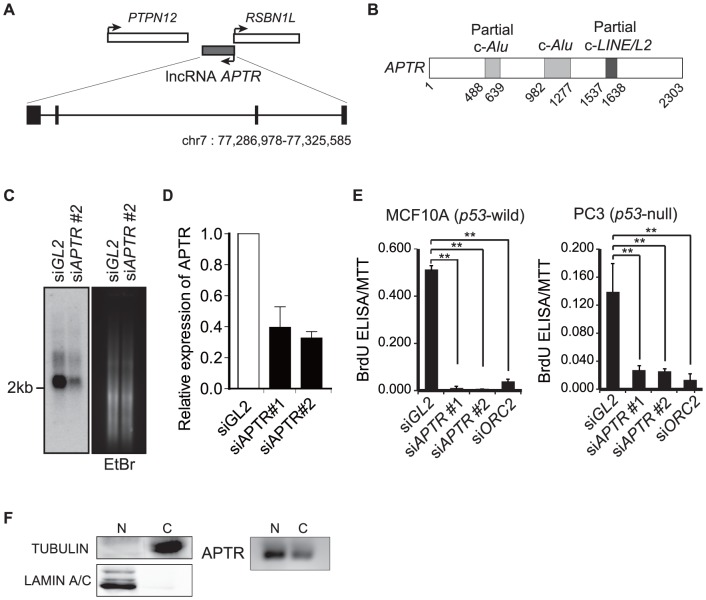
LncRNA APTR knockdown inhibits cell proliferation in a p53-independent manner.(A) Schematic of the APTR locus. Black boxes represent exons. (B) Schematic of lncRNA APTR. “c-“: complementary to Alu or LINE elements. (C) Northern blot of APTR on poly(A) RNA in 293T cells transfected with siGL2 or siAPTR#2, at 72 hr after siRNA transfection. Probe: APTR cDNA (651–950). (D) Relative APTR expression levels normalized to GAPDH in 293T cells transfected with siGL2 or siAPTR#1, #2, at 72 hr after siRNA transfection. (E) APTR knockdown inhibits cell proliferation. BrdU incorporation (DNA synthesis) was measured by BrdU ELISA, 72 hr after siRNA transfection, and normalized to MTT assays (number of viable cells). siOrc2 was used as a positive control known to inhibit cell proliferation. **: P<0.005. (F) Subcellular expression levels of APTR in 293T cells. α-TUBULIN and LAMIN A/C were analyzed as markers for cytoplasm or nuclear fraction (left panel). APTR expression levels in the fractions were analyzed by RT-PCR (right panel).